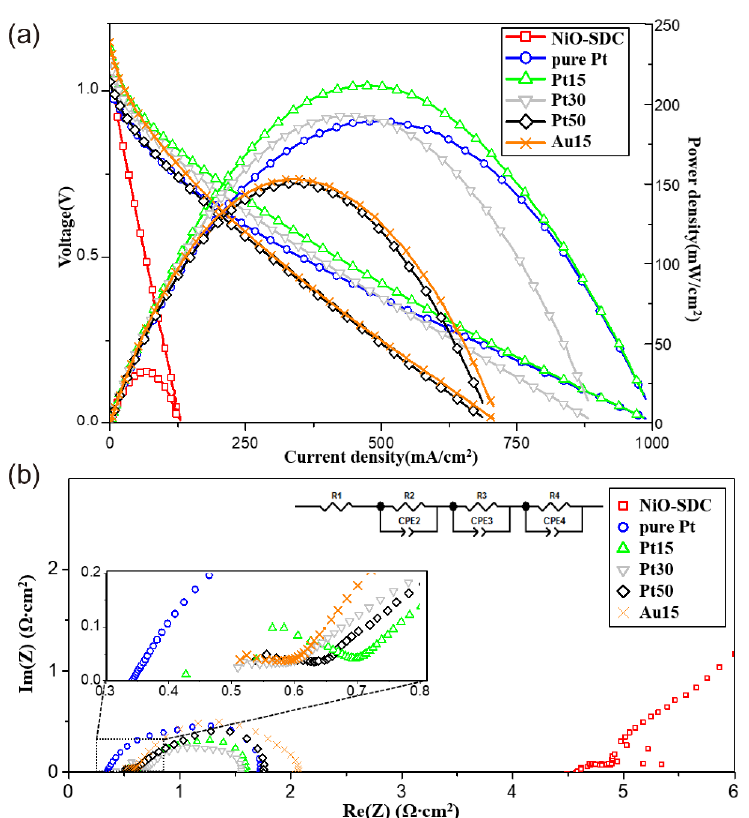
Figure 4. ( a ) Polarization curves of TF-SOFCs at 500 ◦ C with anodes of NiO-SDC, pure Pt, Pt15 / NiO-SDC, Pt30 / NiO-SDC, Pt50 / NiO-SDC, and Au15 / NiO-SDC. ( b ) Nyquist plots of the impedance spectra with the corresponding equivalent circuit model at 0.7 V bias and 500 ◦